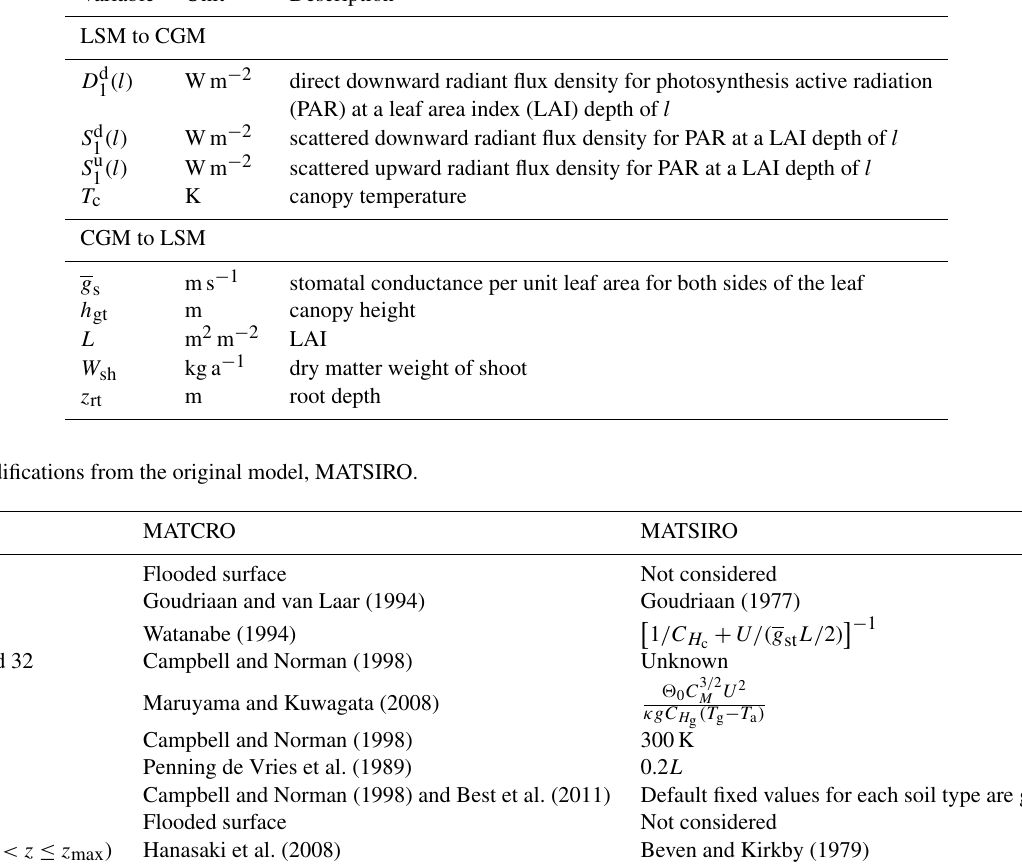
Table 2. Variables exchanged between the land surface model (LSM) and crop growth model (CGM). Variable